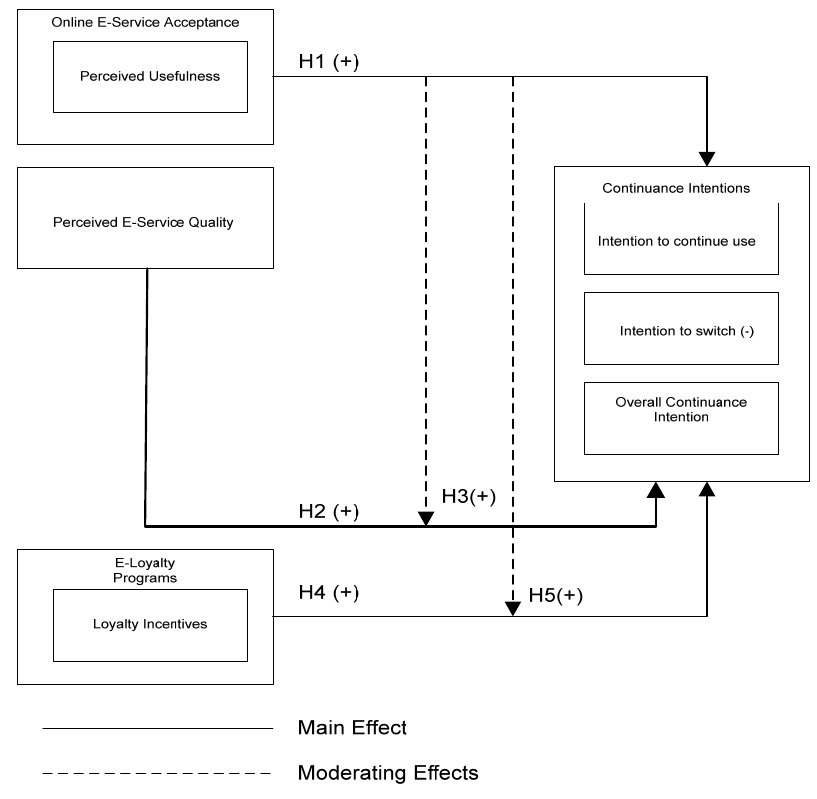
Figure 1: e-Service Continuance